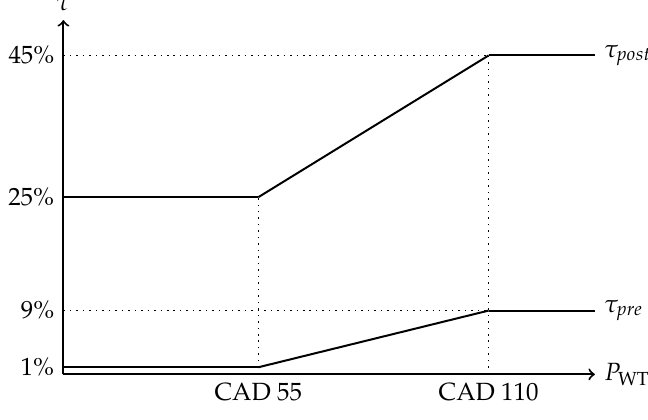
Figure 2. Royalty Rate